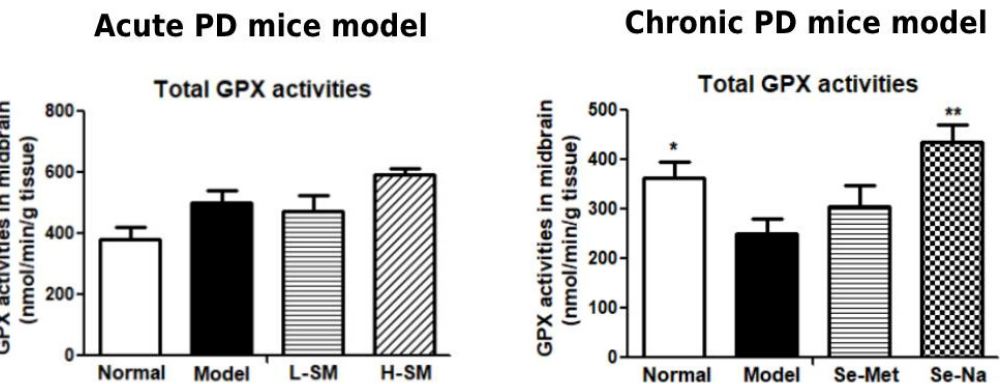
Figure 4. Comparative effects of Se-Na and Se-Met on GPX activities in the brain. Total GPX activities in the midbrain of mice from both acute and chronic PD experiments were measured by commercial ELISA kit and expressed as nmol/min/g tissue. Values are expressed as mean ± SEM, n = 6–8. * p < 0.05, ** p < 0.01 vs. Model group. Se-Na, sodium selenite; Se-Met, Seleno-L-methionine; GPX, glutathione peroxidase; PD, Parkinson’s disease.